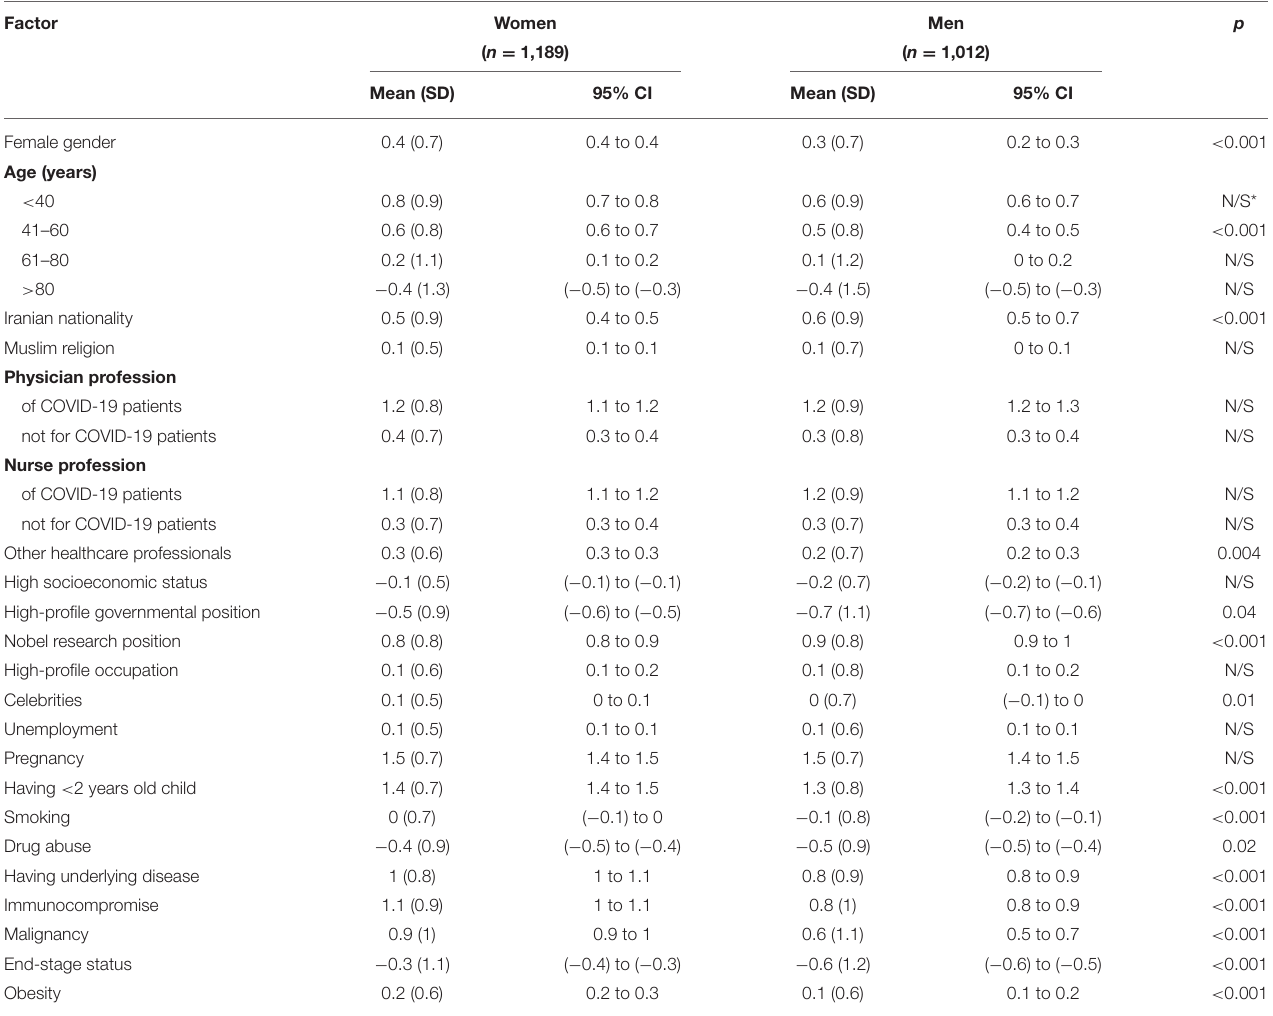
TABLE 4 | The mean priority score assigned to each sub-group of patients with COVID-19 among men and women. Factor Women